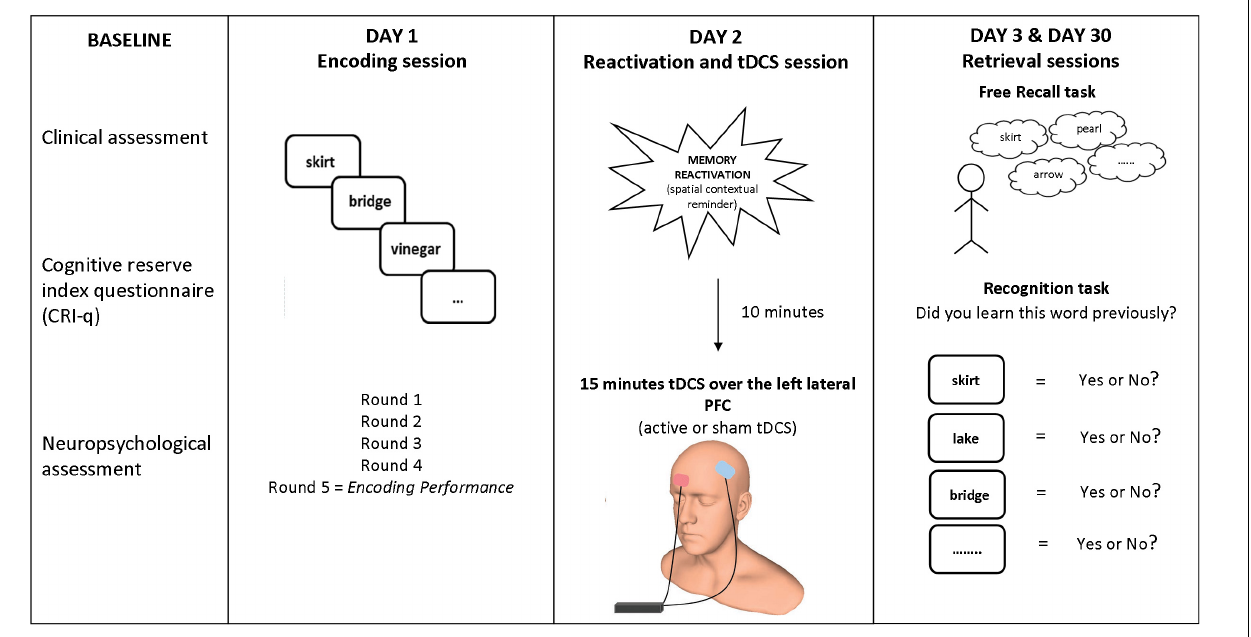
FIGURE 1 | Experimental paradigm. Participants learned 20 words on Day 1. On Day 2 (24 h later), tDCS (active or sham) was applied over the left lateral PFC (anode over left PFC and cathode over the right supraorbital area) after a spatial contextual reminder. Memory retrieval (free recall and old/new recognition) was tested 48 h later (Day 3) and 30 days later (Day 30). Human head model from http://www.ir-ltd.net/. Used by Creative Commons